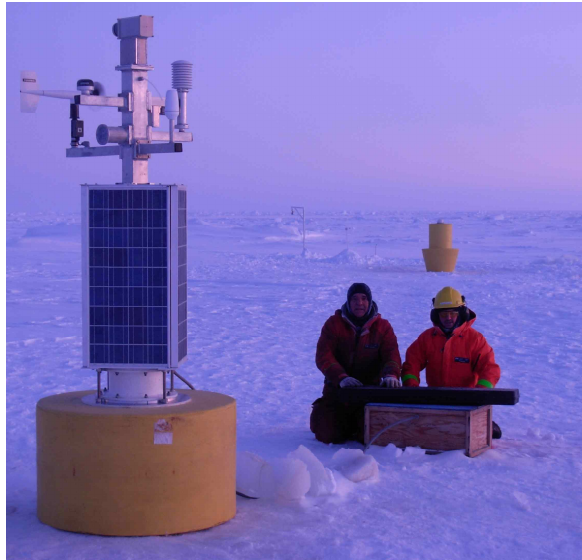
Fig. 6. Photograph of the O-buoy, solar panel array, and lead-acid battery box as deployed on the Beaufort Sea. The lead acid packs (inside wooden box) are connected to the buoy via shielded cable in a manner that allows the lead acid batteries to tear away from the buoy in the event of a significant ice break up. Should this happen, the buoy will stay on via diode switching with power from the in- ternal lithium ion packs. Future versions will have larger flotation collars with cavities to store the lead acid